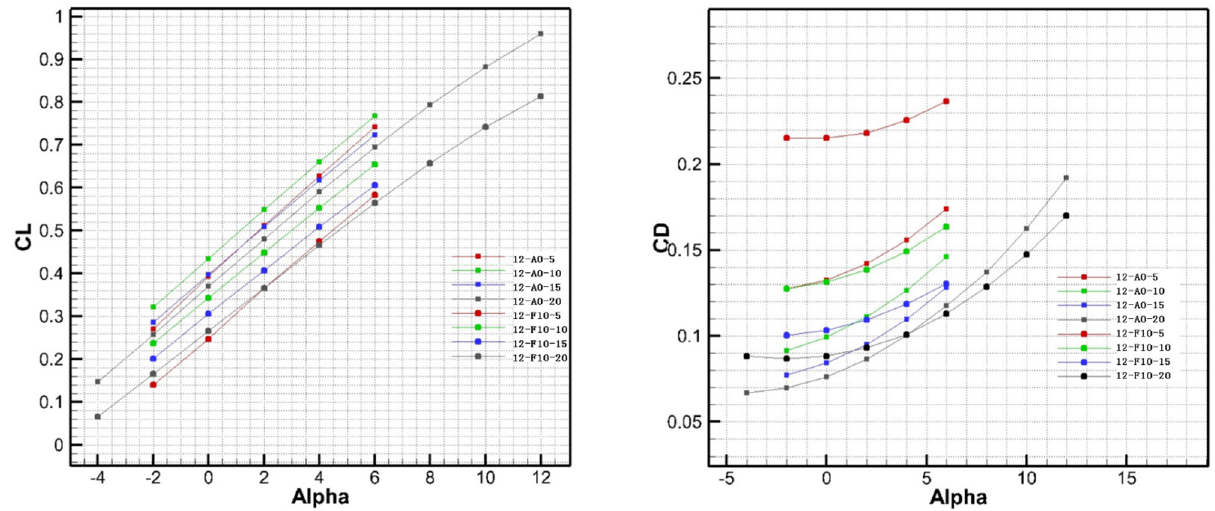
Figure 6. UAV lift and drag coefficient schematic diagram of force during transition flight.